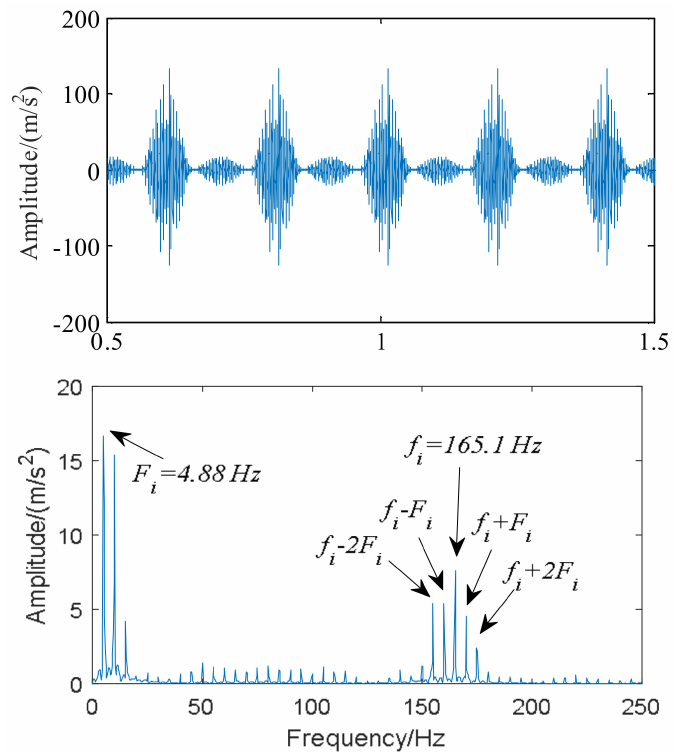
Figure 15. Time–domain signal and envelope spectrum of IR fault (numerical simulation).